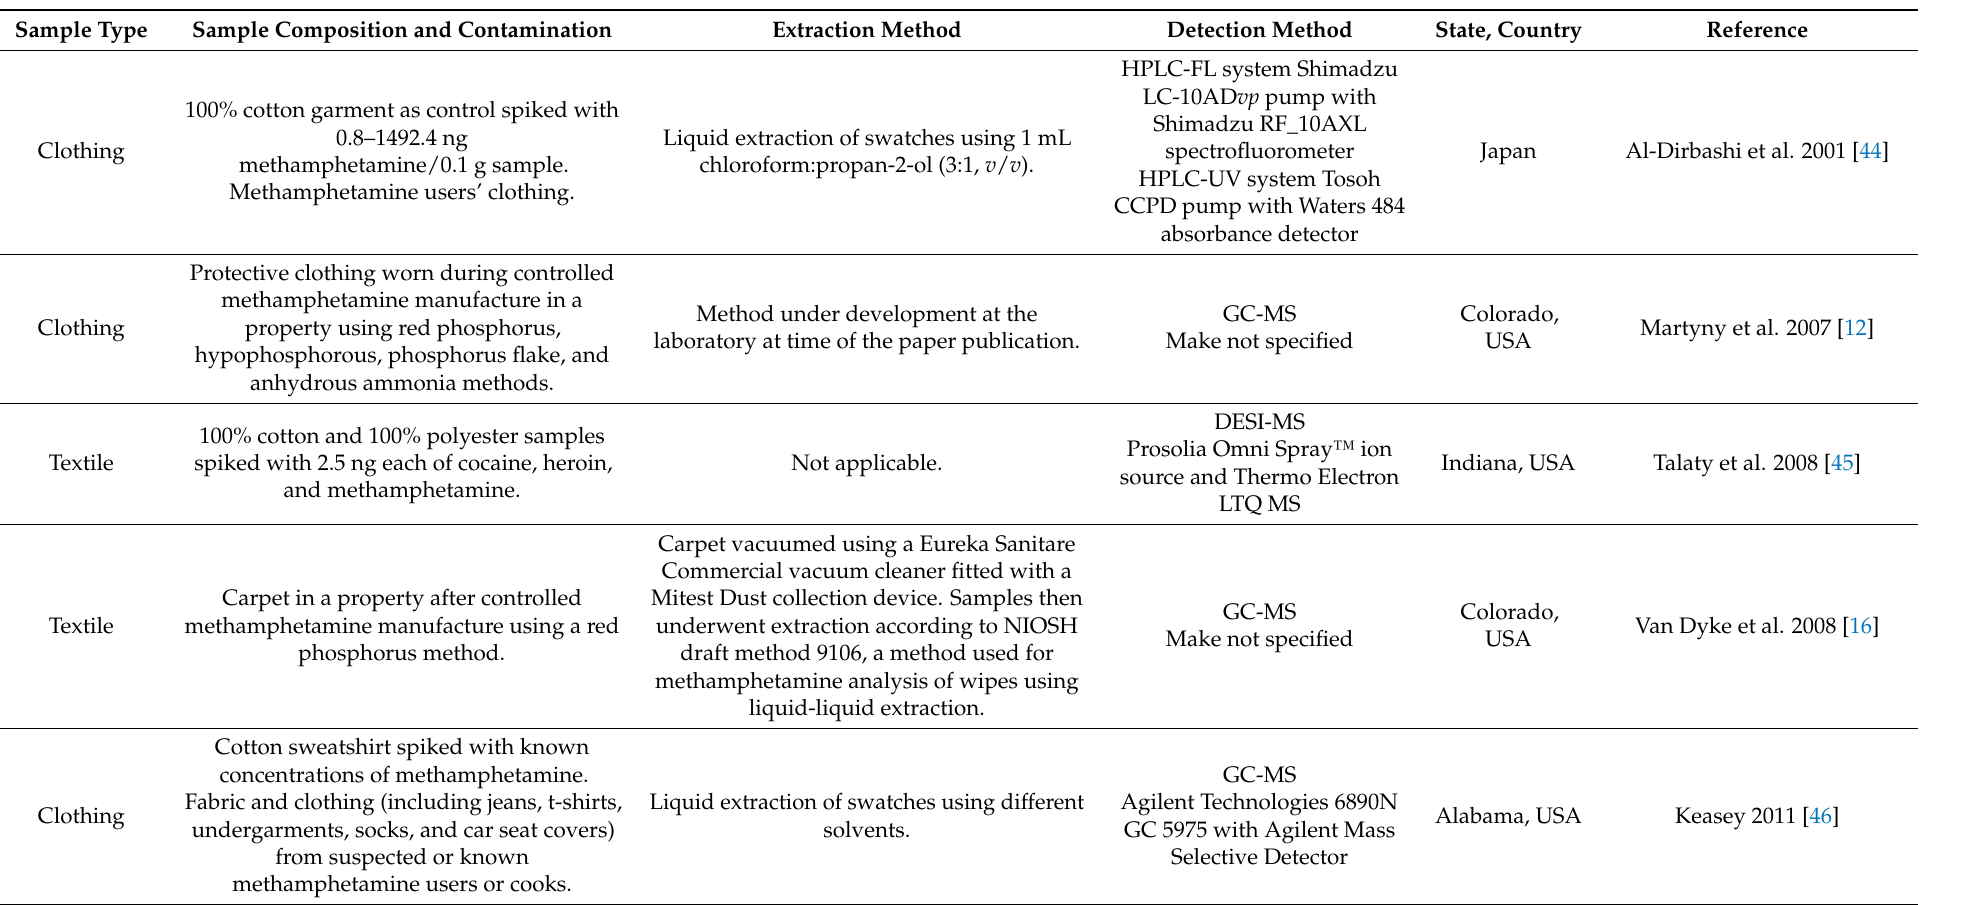
Table 3. Summary of textile and clothing studies identifying the sample type, sample composition and contamination, and the extraction and detection